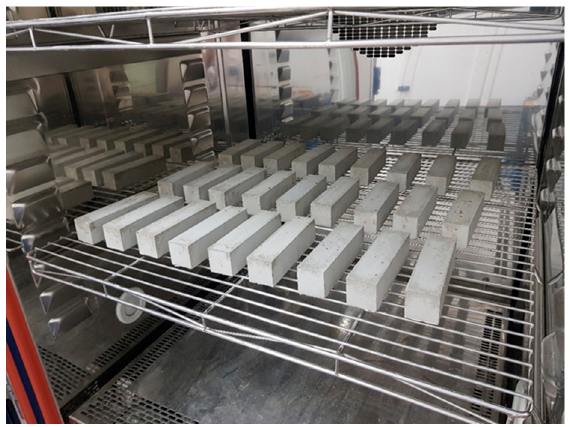
Figure 1. View of the samples in a climatic chamber during the test.